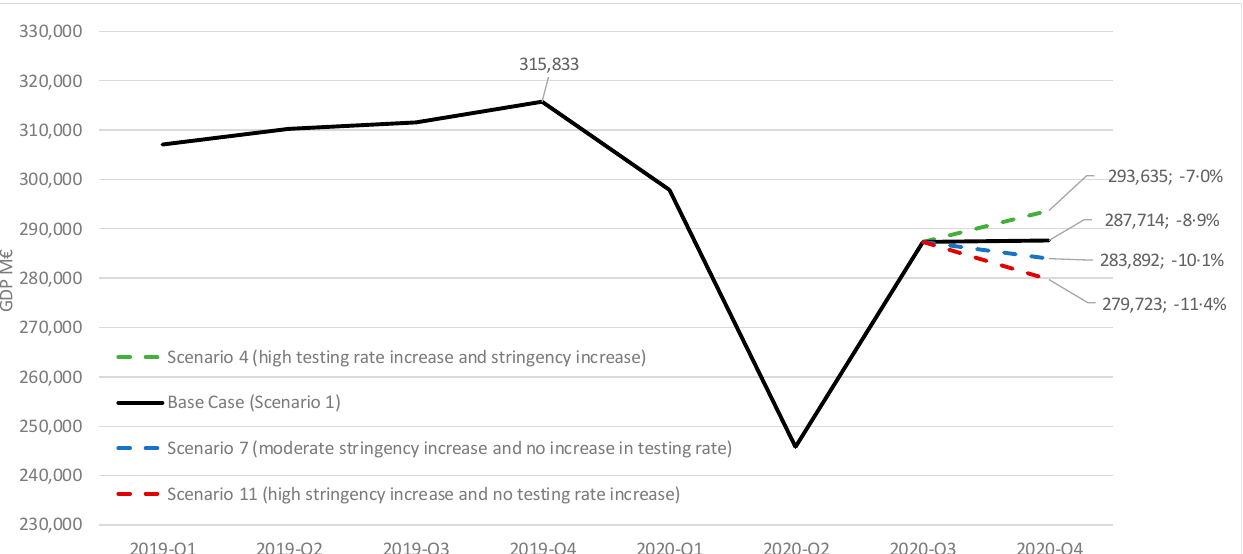
Results from the regression model indicated that lower positivity rates (higher testing rate), lower case fatality rate, higher GDP industry share, and lower Stringency Index correlated with lower GDP decline during Q2 2020 (Table S4 and Figure S3). When applying the coefficients for stringency and testing rates to the different scenarios, a difference of up to 4.4% points is observed for Q4 2020 GDP (Figure 6). For instance, scenario 4 (high testing rate increase with no stringency increase) is associated with a 8.9% drop in GDP, 1.9% points lower than our base case (scenario 1), whereas scenarios 7 and 11 (moderate and high stringency increase, respectively, with no testing rate increase) are associated with GDP drops of 10.1% and 11.4%, respectively, 1.2% and 2.5% points higher than our base case.